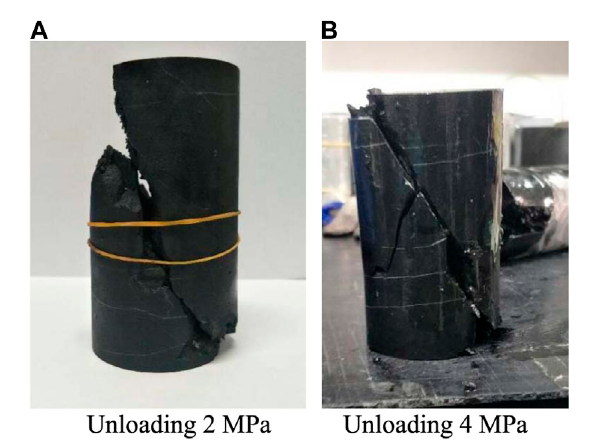
FIGURE 8 The creep failure modes of graded unloading under different unloading amounts. (A) Unloading 2 MPa (B) Unloading 4 MPa.